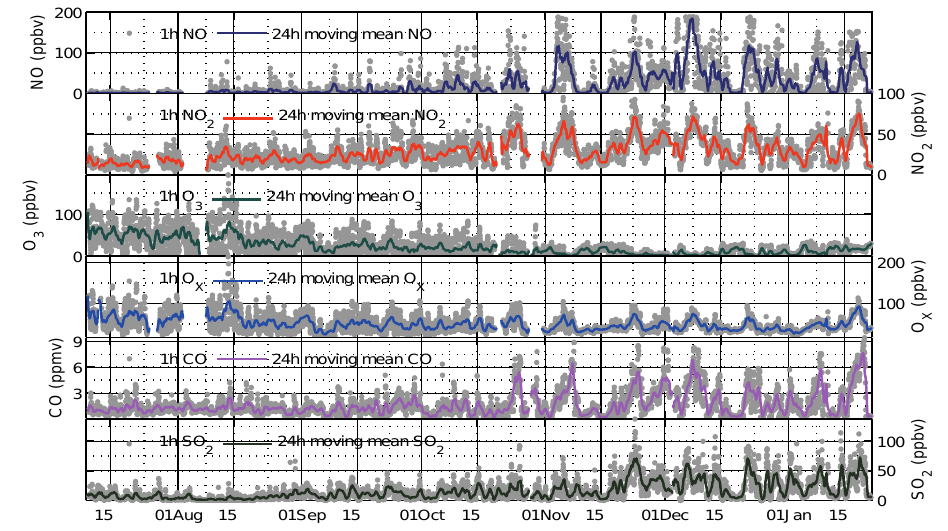
Fig. 5. 1-h average and 24-hour moving average NO, NO 2 , O 3 , O x , CO, SO 2 mixing ratio time